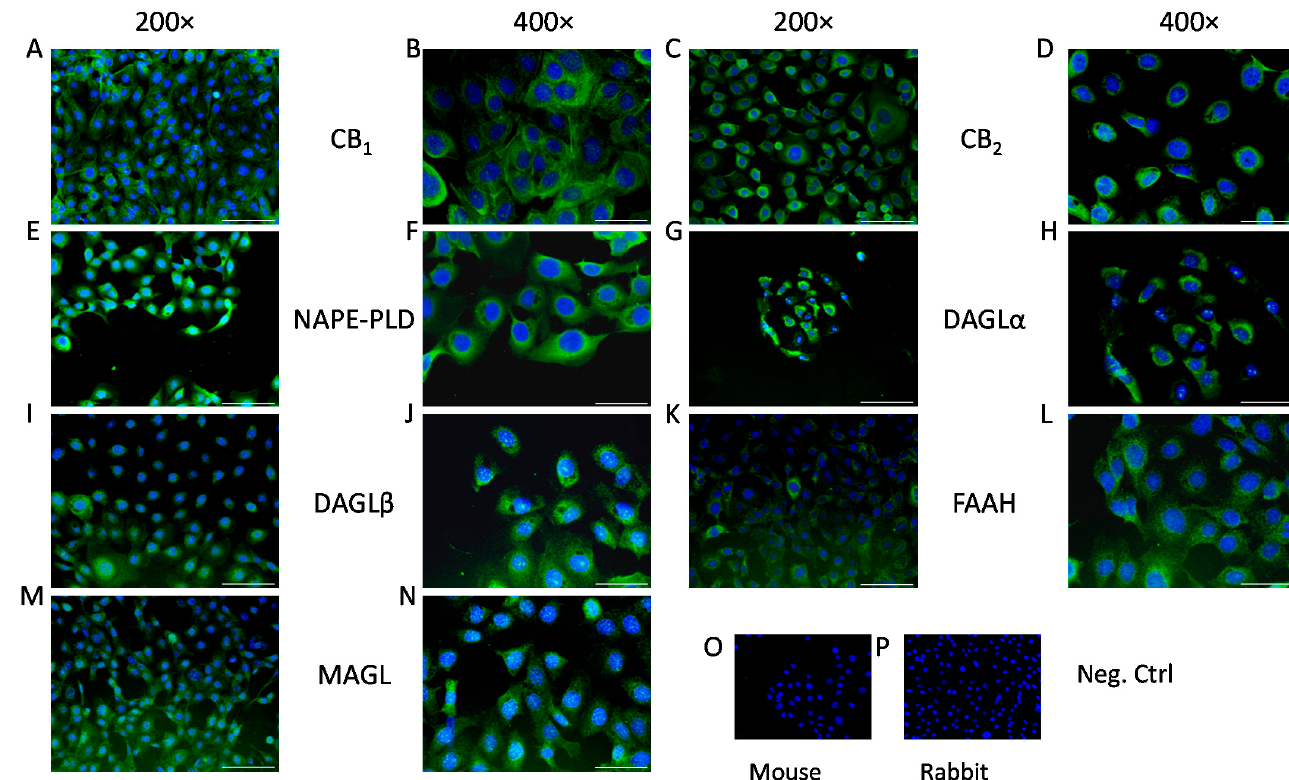
Figure 1. Human corneal epithelial cells express endocannabinoid receptors and endocannabinoid metabolizing enzymes in vitro: ( A , B ) CB 1 -specific, ( C , D ) CB 2 -specific, ( E , F ) NAPE-PLD-specific, ( G , H ) DAGL α -specific, ( I , J ) DAGL β -specific, ( K , L ) FAAH-specific, and ( M , N ) MAGL-specific immunoreactivity, as shown by immunofluorescence (green fluorescence) on human corneal epithelial cell cultures. Nuclei were counterstained with DAPI (4 ′ ,6-diamidino-2-phenylindole; blue fluorescence). ( O ) Negative control of panels C, D, G–N; ( P ) negative control of panels A, B, E, and F. Scale bars mark 100 μ m or 50 μ m, depending on magnification (200× and 400×, respectively).